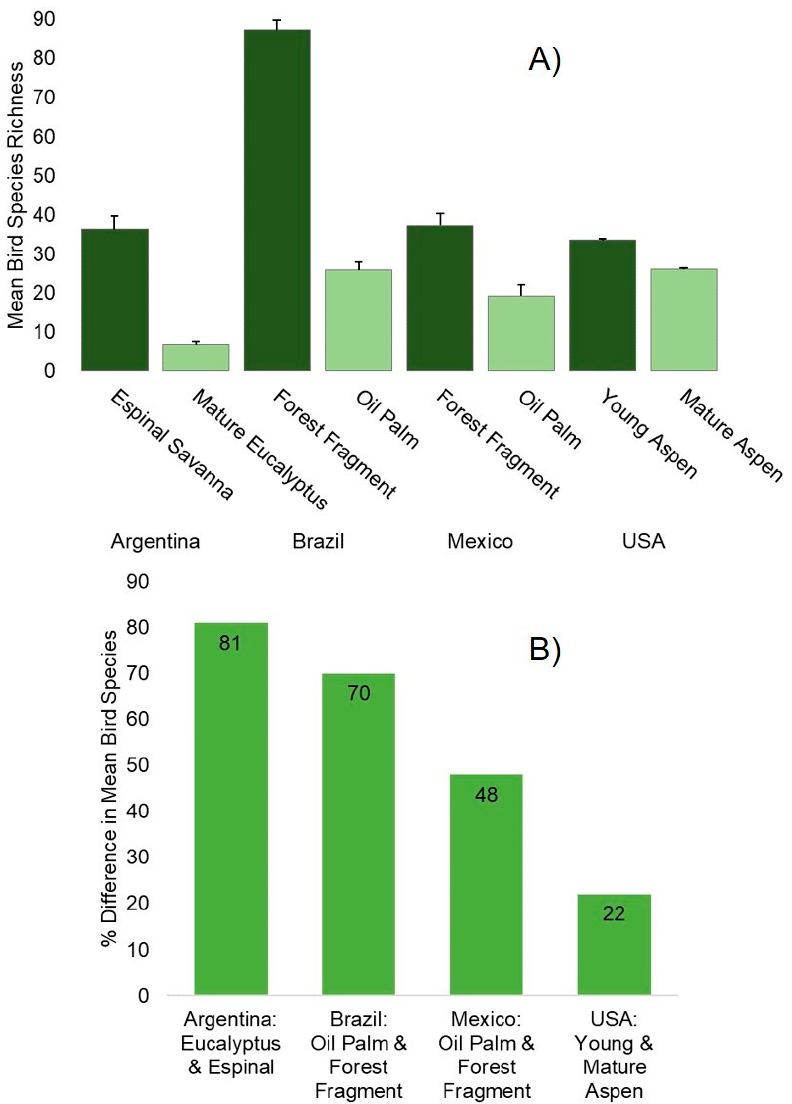
Figure 2. ( A ) Differences in mean bird species richness between feedstock/harvested landscapes and native/unharvested landscapes in each of the four study countries. Error bars are +1 standard error of the mean. ( B ) Percent differences in mean bird species richness between feedstock/harvested landscapes and native/unharvested landscapes in each of the four study countries.